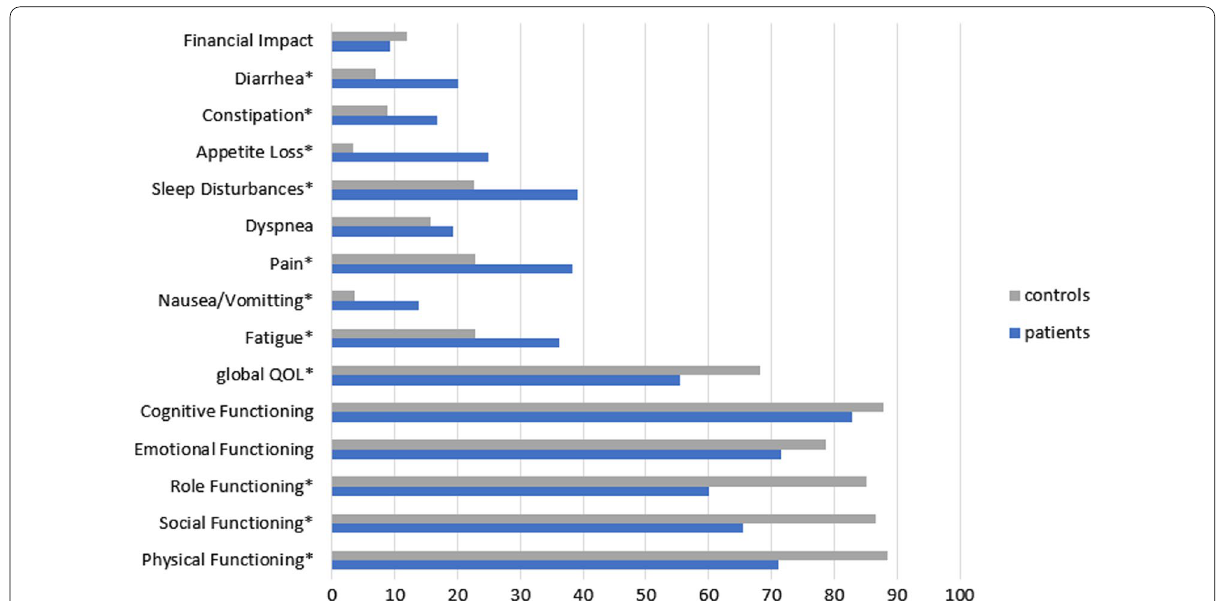
Fig. 2 Health‑related quality of life differences between patients and general population controls as measured with the QLQ‑C30. The group differences in HRQOL domains regarding the cancer patient sample (N 40) and the control group from the general population (N = from the scale for constipation ( p 0.05), all significant differences showed p values 0.003; all statistical significant differences met the criteria for a = ≤ clinical relevance based on Cocks et al.